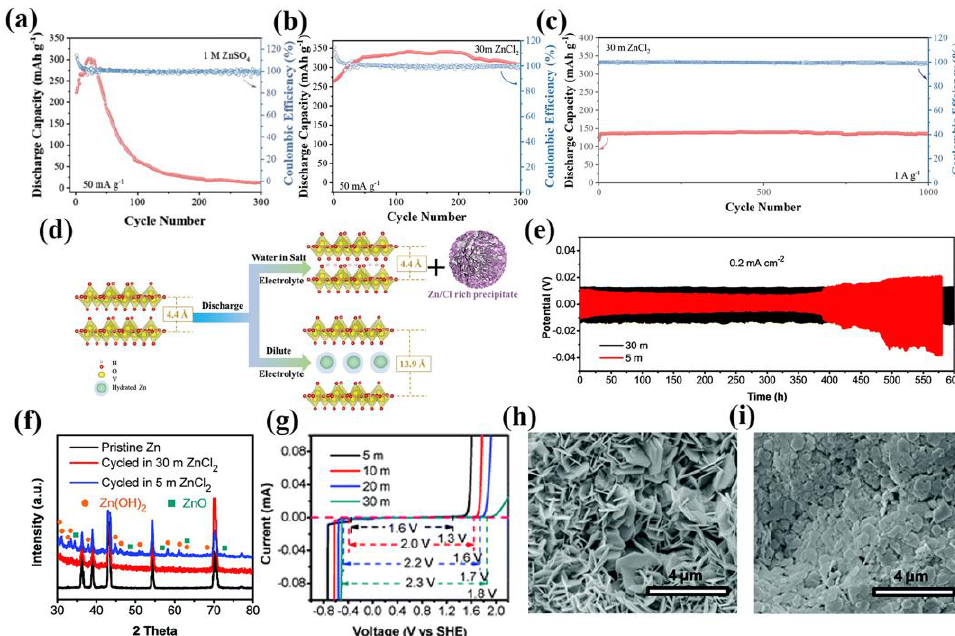
Figure 5. Cycling performance of the bulk V 2 O 5 cathode in ( a ) 1 m ZnSO 4 and 30 m ZnCl 2 . ( b ) at a current density of 50 mA g − 1 . ( c ) Long-cycling performance of V 2 O 5 in WISE at 1 A g − 1 . ( d ) Schematic illustration of the dynamic structural evolution for V 2 O 5 cathode in different electrolytes. Adapted with permission from Ref. [59]. Copyright 2021 Advanced Science. ( e ) The plating/stripping and ( f ) XRD patterns of Zn in 5 and 30 m ZnCl 2 in a Zn||Zn symmetric cell at 0.2 mA cm − 2 with 10